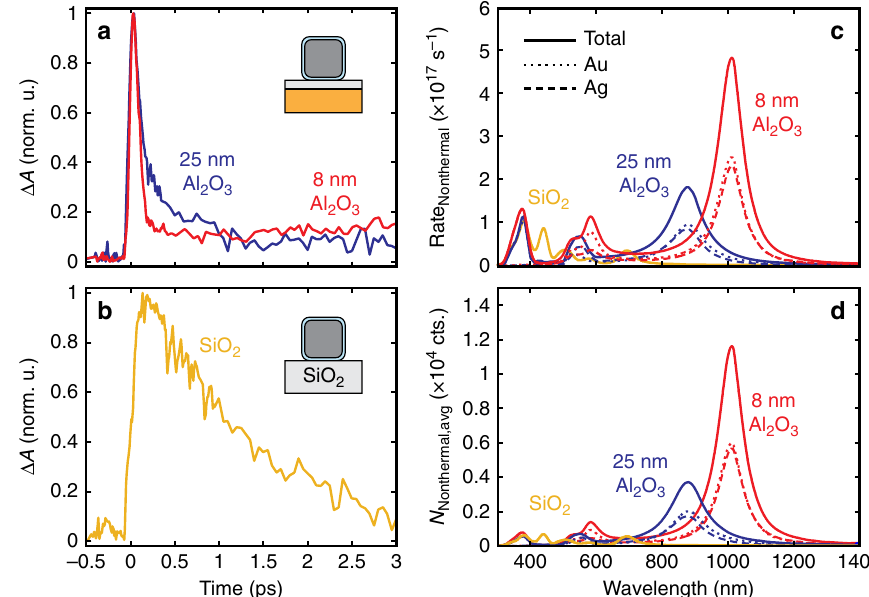
Fig. 4 Enhanced generation and detection of nonthermal electrons in metasurface geometry. a Kinetic trace of normalized differential absorbance for Ag nanocubes on an 8 nm Al 2 O 3 spacer compared to a 25 nm Al 2 O 3 spacer at the gap resonance and ( b ) to bare Ag nanocubes on SiO 2 in transmission mode, which exhibits no ultrafast (~100 fs) decay of the response. The 8, 25 nm, and SiO 2 samples were, respectively, pumped/probed at 1100/1120, 900/920, and 500/365 nm with incident fl uences of 40, 40, and 500 μ J cm − 2 (absorbed fl uence kept constant). The ~100 fs response arises from the relaxation of highly energetic nonthermal carriers. c , d Comparison between nonthermal carrier generation rate ( c ) to estimates of the peak nonthermal carrier density ( d ) as a function of geometry and pump wavelength. A much larger contribution to the signal is expected for excitations in the